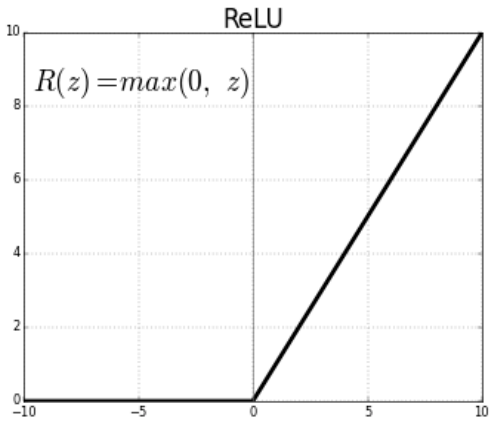
Figure 2. ReLU activation function.